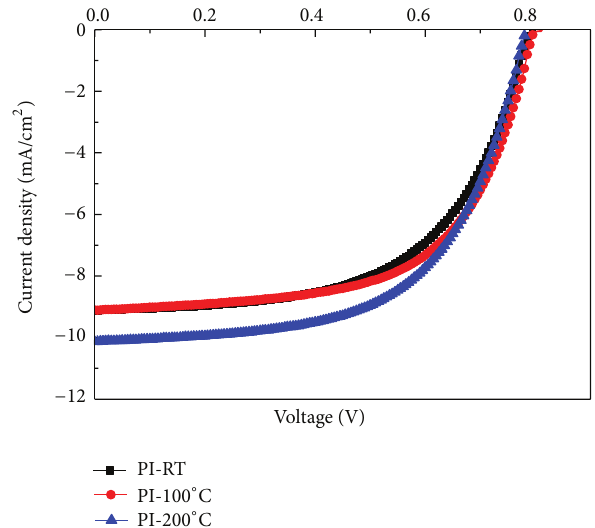
Figure 8: Current-voltage characteristics of the p-i-n 𝛼 -Si:H thin- film solar cells under